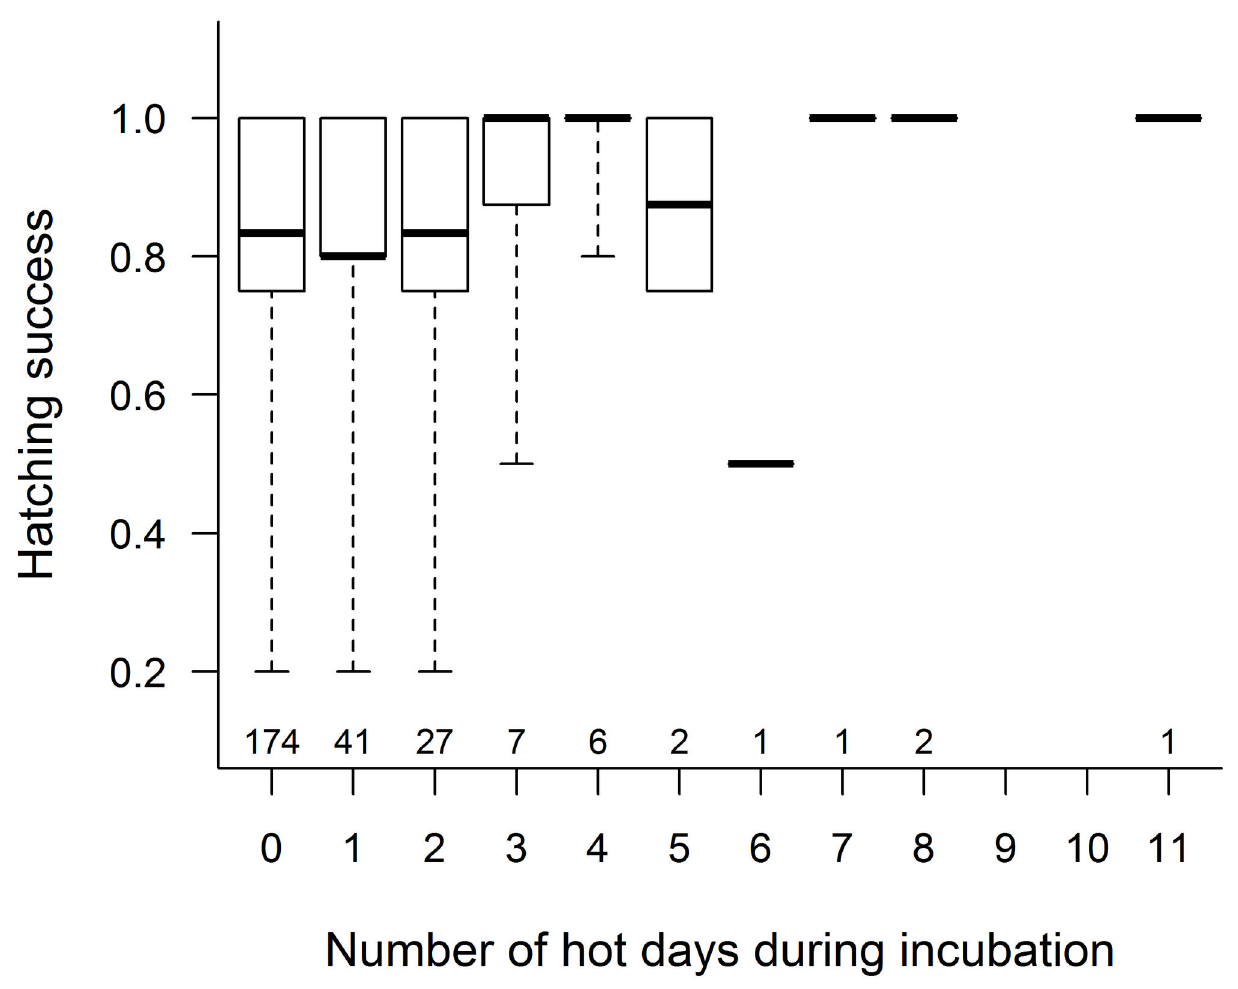
Figure 2. Relationship of hatching success with the number of hot days during incubation. Box plots show the median (thick line), interquartile range (box) and the range of data (whiskers); sample sizes are shown below each box. doi: